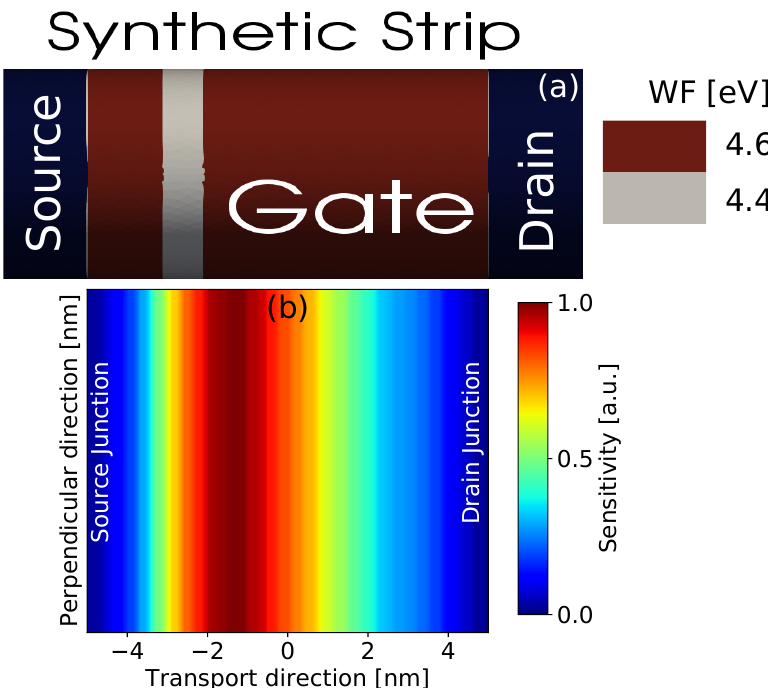
Figure 7. ( a ) Schematic of a 10 nm gate length GAA-NW FET affected by a synthetic MGG profile. The WF is 4.6 eV in all the gate except from a narrow strip (0.1 nm wide) with a WF 4.4 eV. ( b ) 2D on-current FSM generated from the simulation of 100 synthetic gate profiles swept along the device at a 0.7 V drain